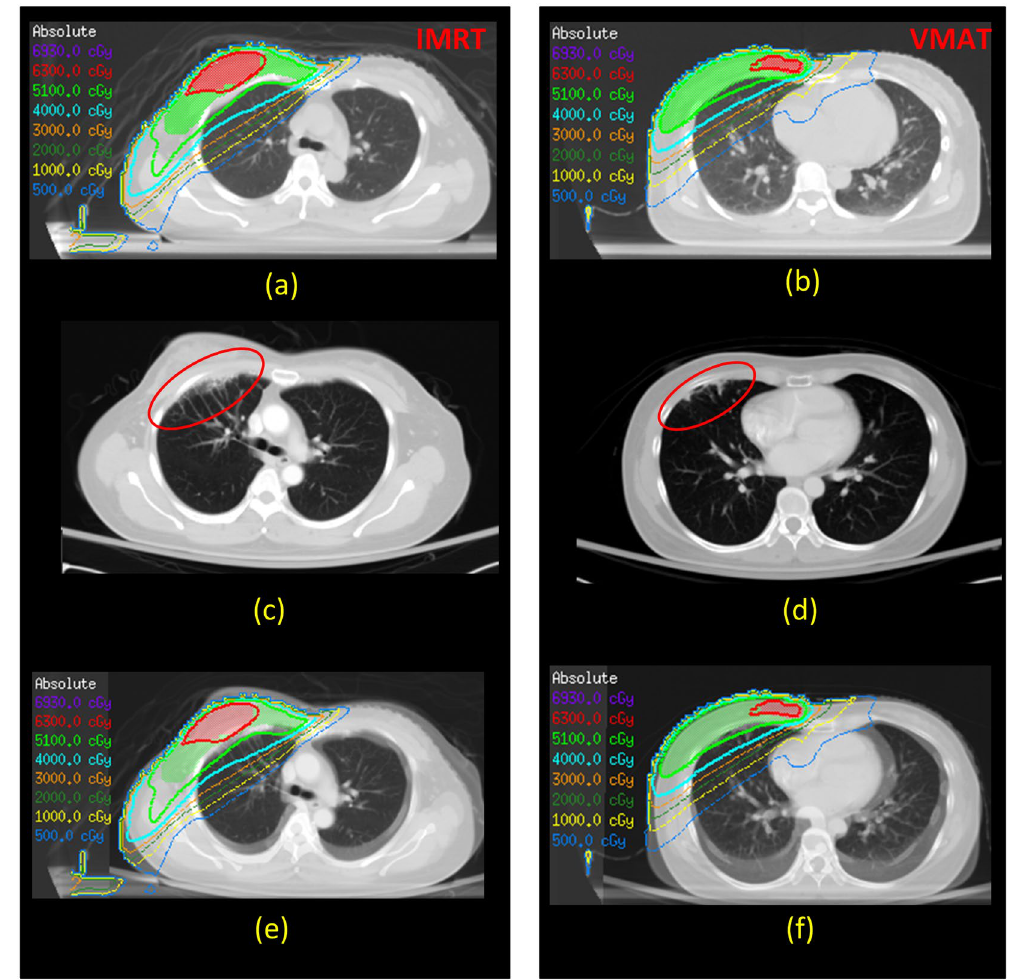
pneumonitis; IMRT, intensity-modulated radiotherapy; VMAT, volumetric-modulated arc